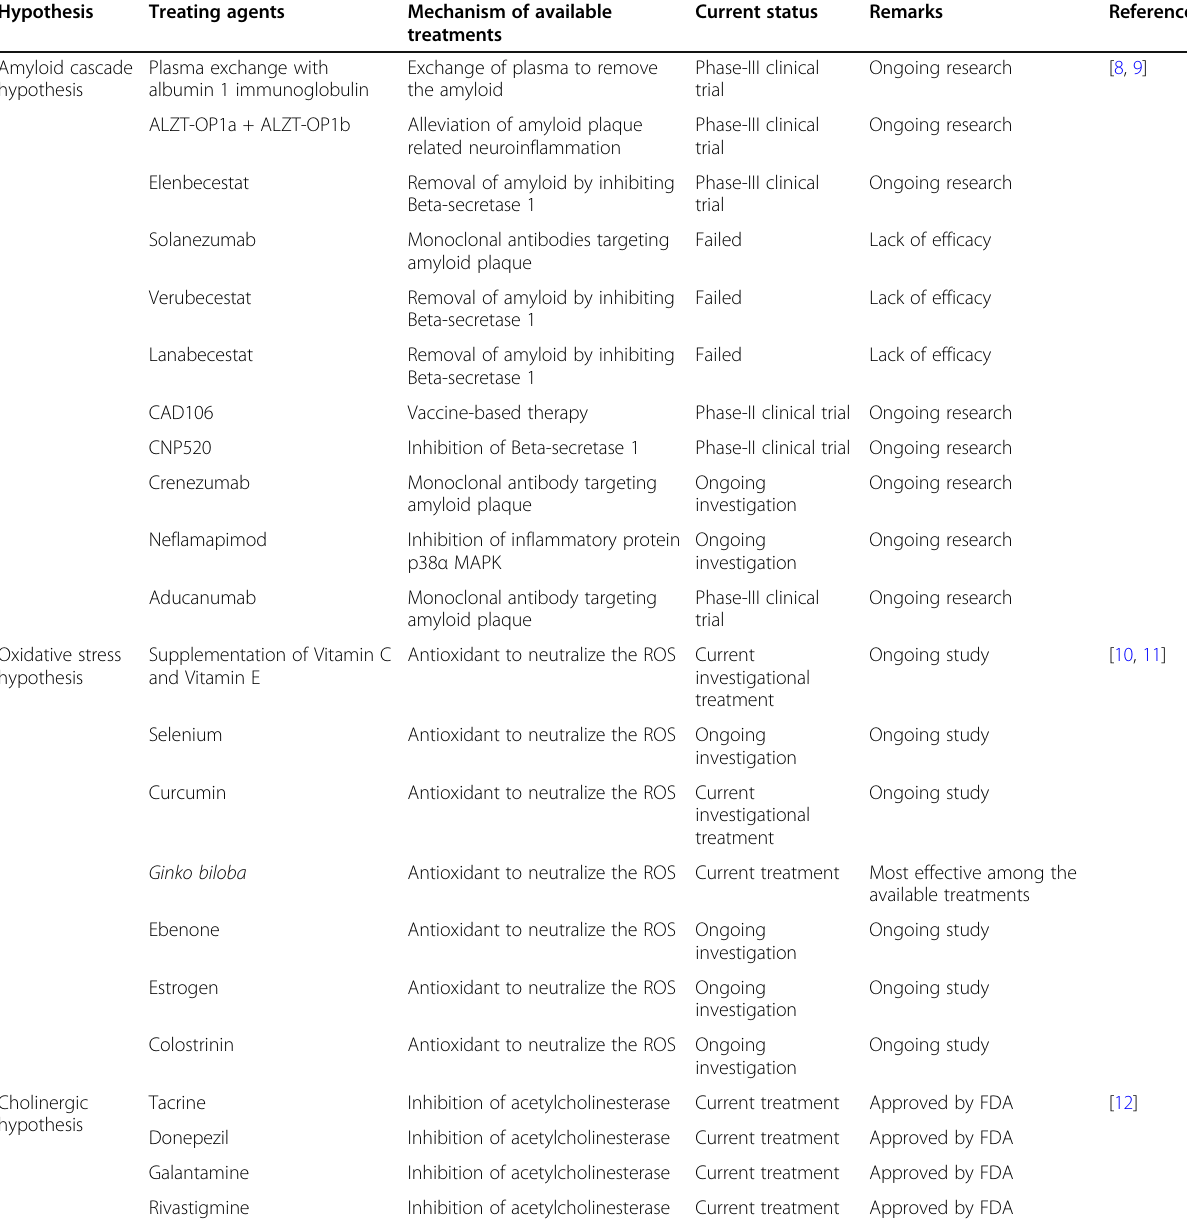
Table 1 Examples of AD treating agents, their mechanism of treatment, and their current status Hypothesis Treating